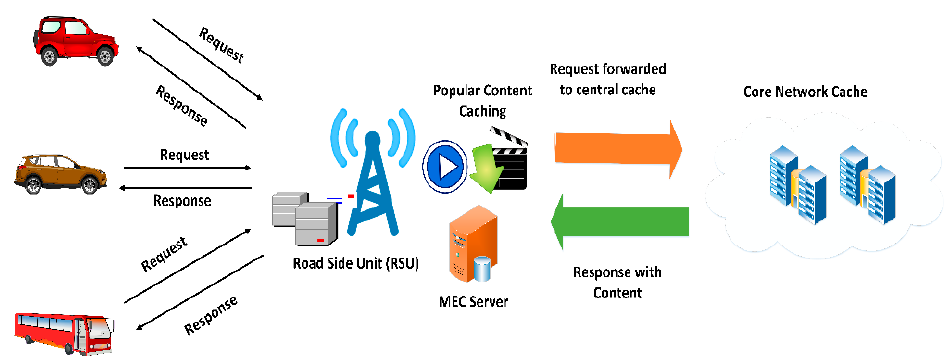
Figure 2. Content caching in VENs.